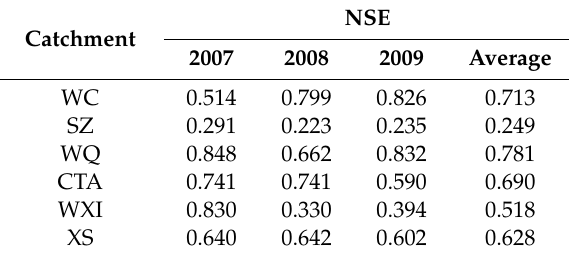
Table 5. Accuracy statistics of the Xinanjiang module in